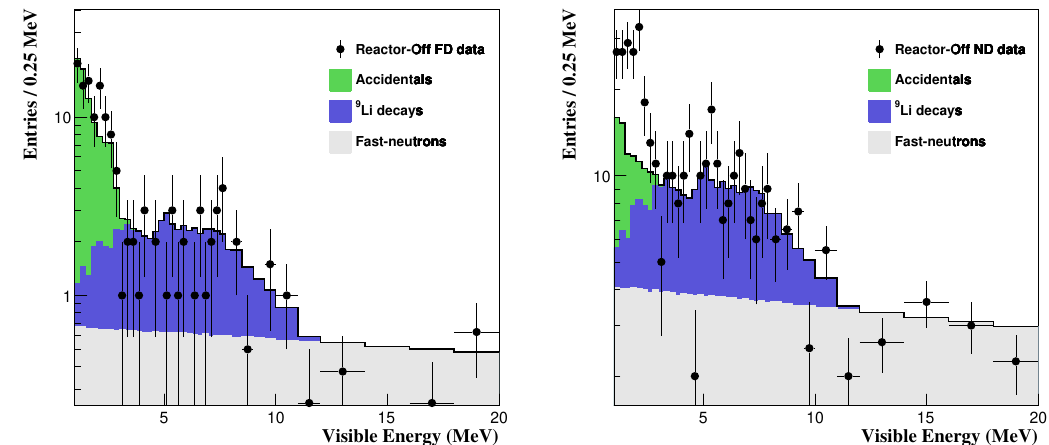
Figure 3 . Reactor-off IBD candidates as a function of the visible energy during the MD period. The observed candidates in the FD (left) and the ND (right) are superimposed to the background model described in [9], considering accidental coincidences, fast-neutrons and 9 Li